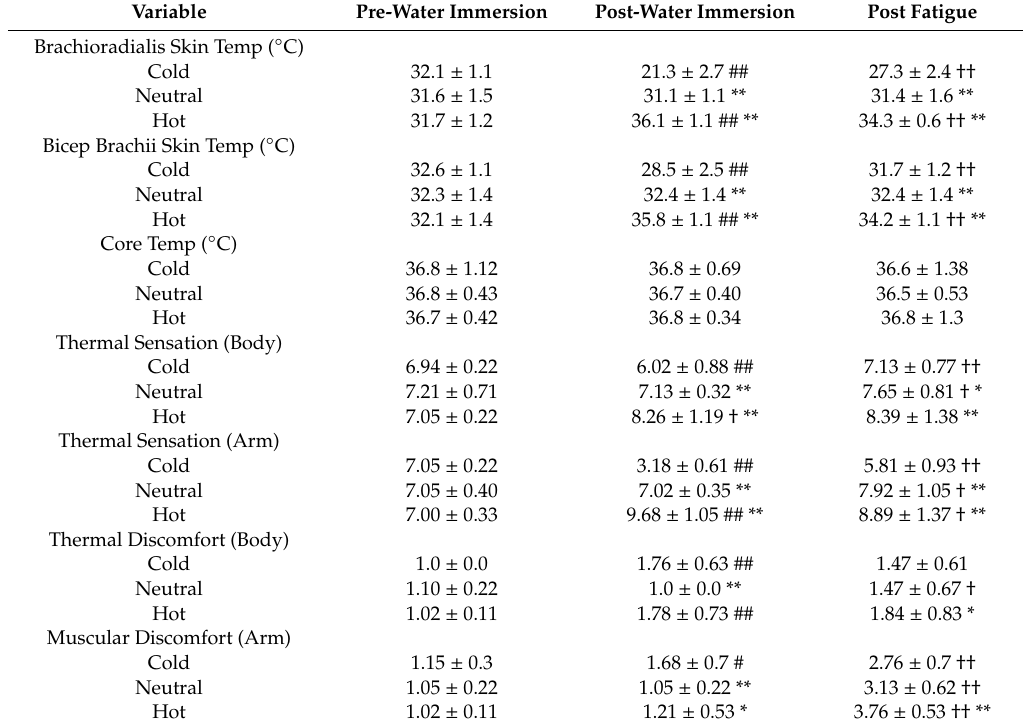
Table 1. Temperature and perceptual measures throughout the